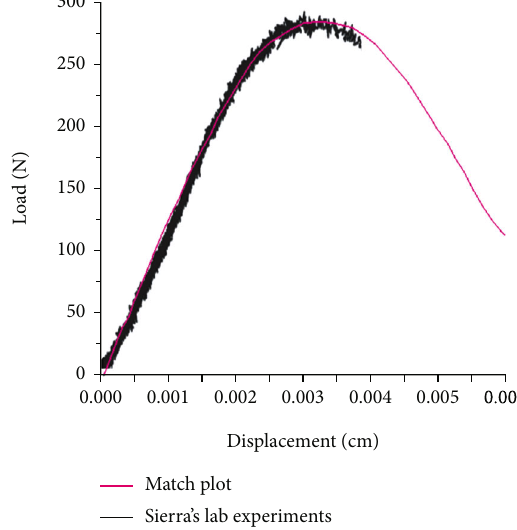
Figure 2: Determining cohesive parameters using SCBT: (a) divided mesh where the red line denotes the embedded cohesive interface and (b) experimental sketch.